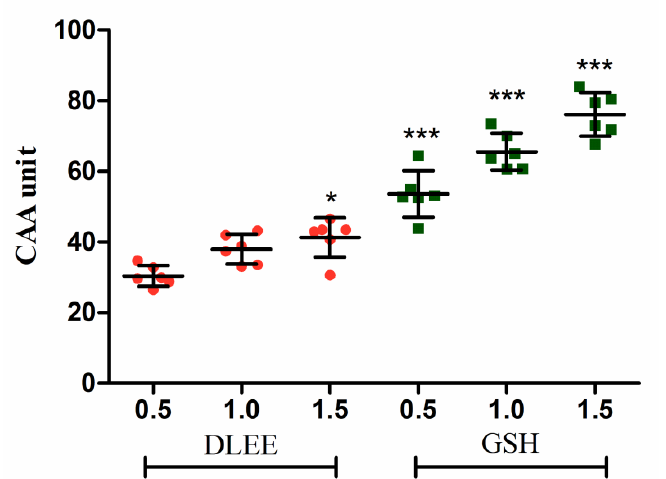
Figure 1. The cellular antioxidant activity (CAA) in Caco-2 cells. Cells were treated with 0.5, 1.0, or 1.5 mg/mL of peptides for 2 h, followed by 25 μ M DCFH-DA for 1 h. ABAP (600 μ M) was added 1.5 mg/mL of peptides for 2 h, followed by 25 µ M DCFH-DA for 1 h. ABAP (600 µ M) was added